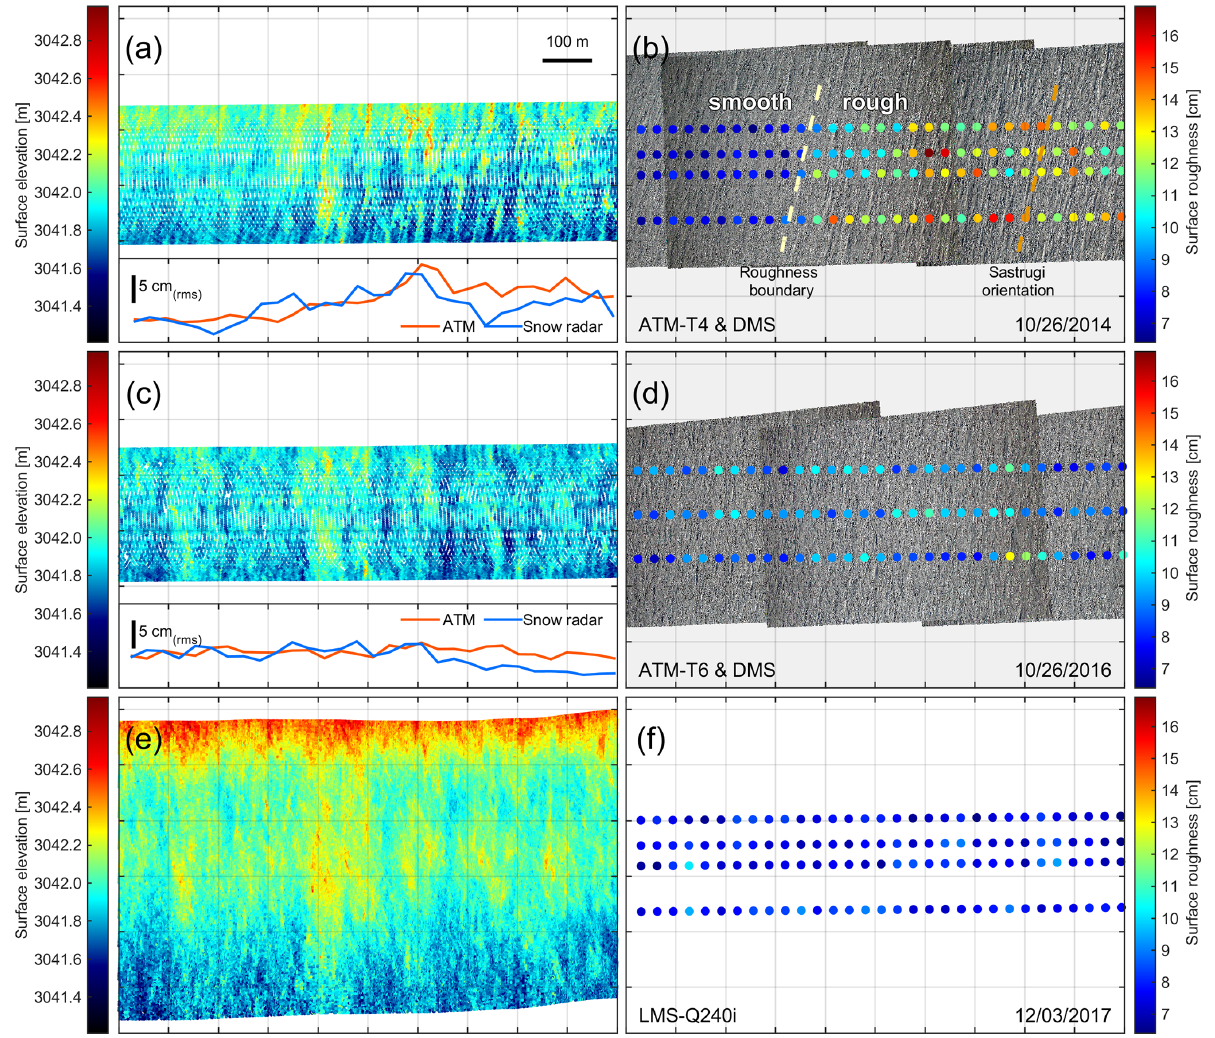
Figure 5. Laser spot elevation measurements and DMS imagery over roughness feature “C” (Fig. 4b). The center of all map panels is at 88.97 ◦ S, 135 ◦ E. All panels cover the exact same area on the ground and are shown in a local coordinate system parallel to the aircraft trajectory. Panels (a) , (c) , and (e) show laser spot elevation measurements in 2014, 2016, and 2017. Inset plots in (a) and (c) show surface roughness from ATM and snow radar at the center of the scan/nadir position. Panels (a) and (c) show small (centimeter level) semicircular elevation biases that are a result of occasional variations in scan azimuth speed (Yi et al., 2015). The peak-to-peak amplitude of these biases is an order of magnitude smaller than the ice surface topography. Panels (b) , (d) , and (f) show corresponding DMS imagery ( b and d only) and surface roughness from laser altimetry in 2014, 2016, and 2017. The darkening towards the edge of the DMS frames in (b) and (d) is caused by vignetting from the lens and not related to geophysical changes. ATM roughness is from ICESSN data, and the UAF Riegl data from 2017 have been calculated in the same way as ATM ICESSN data to make them compatible. A distinct change in roughness can be seen in 2014 that is visible in both the laser-derived surface roughness and the length of the shadows in DMS imagery (b) . The roughness doubles over a distance of ∼ 200m (a) . The orientation of the boundary is parallel to the dominant sastrugi orientation (b) . In 2016 and 2017 the distinct change in roughness seems to have been smoothened